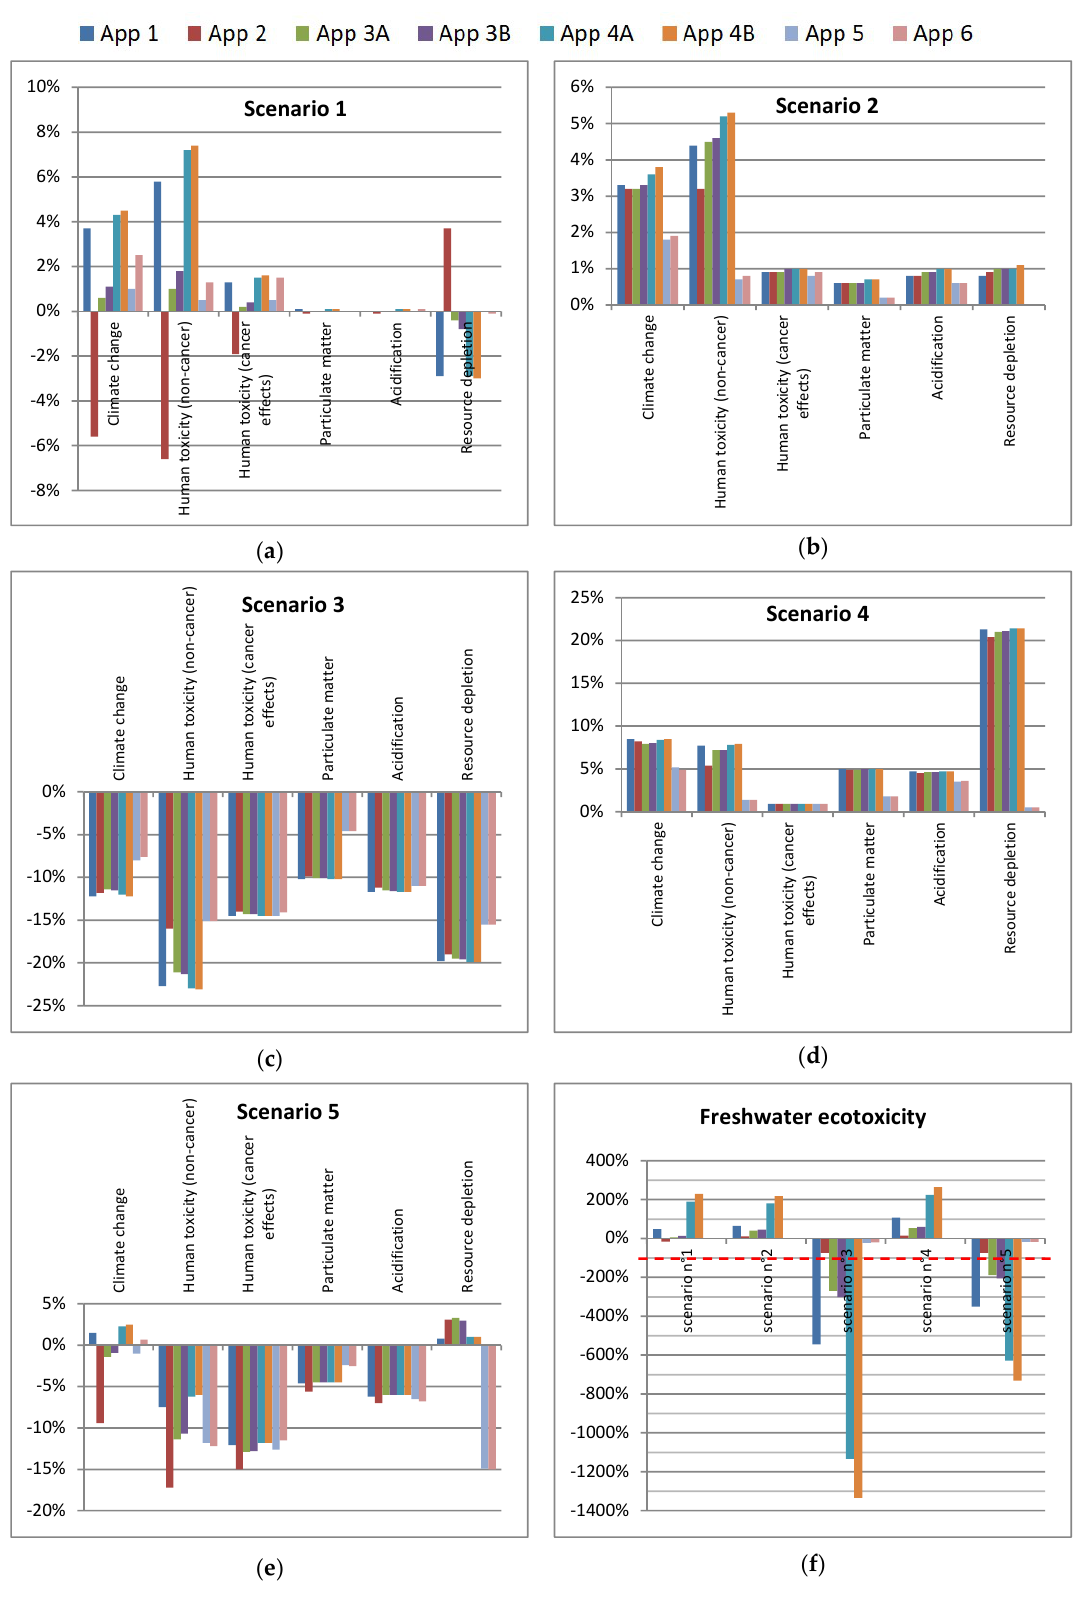
Figure 6. Results from the different scenarios considered in the sensitivity analysis: ( a ) high penetration of renewables, ( b ) increased processing efficiency, ( c ) lower primary material content, ( d ) Optimized collection network, ( e ) combined conditions in 2040, and ( f ) specific plot for ‘freshwater ecotoxicity’.